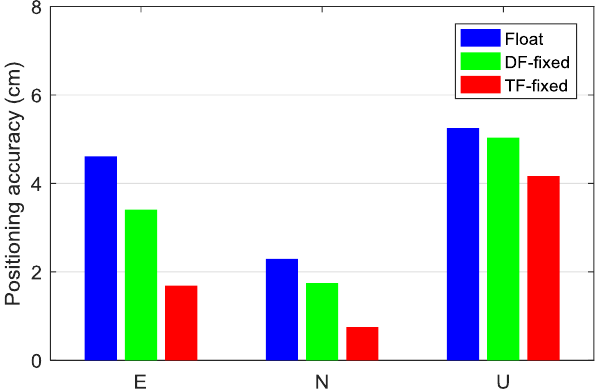
Figure 13. Positioning accuracy of 1-min static LEO-only float and fixed solutions.